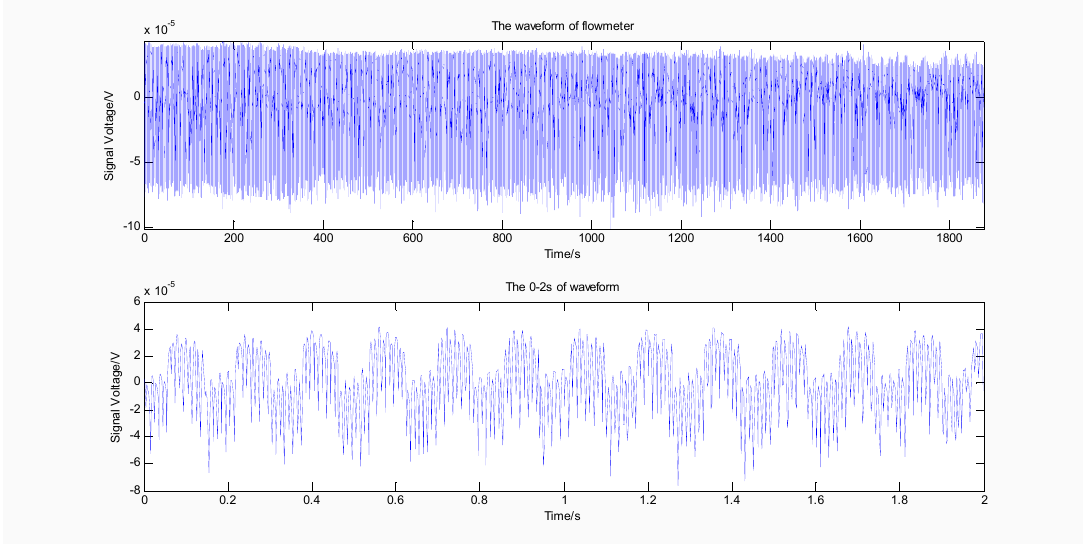
Figure 3. The original flow meter signal.